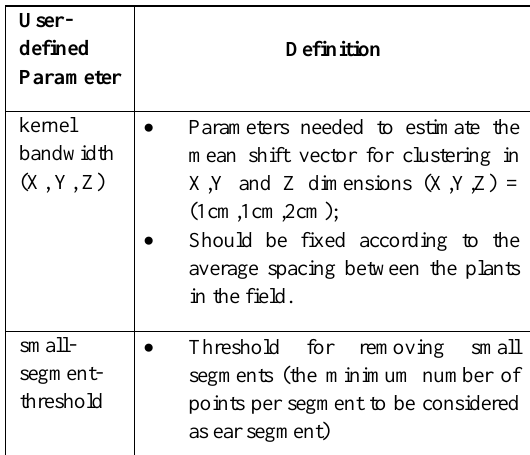
Table 2 User-defined parameters used in mean shift segmentation